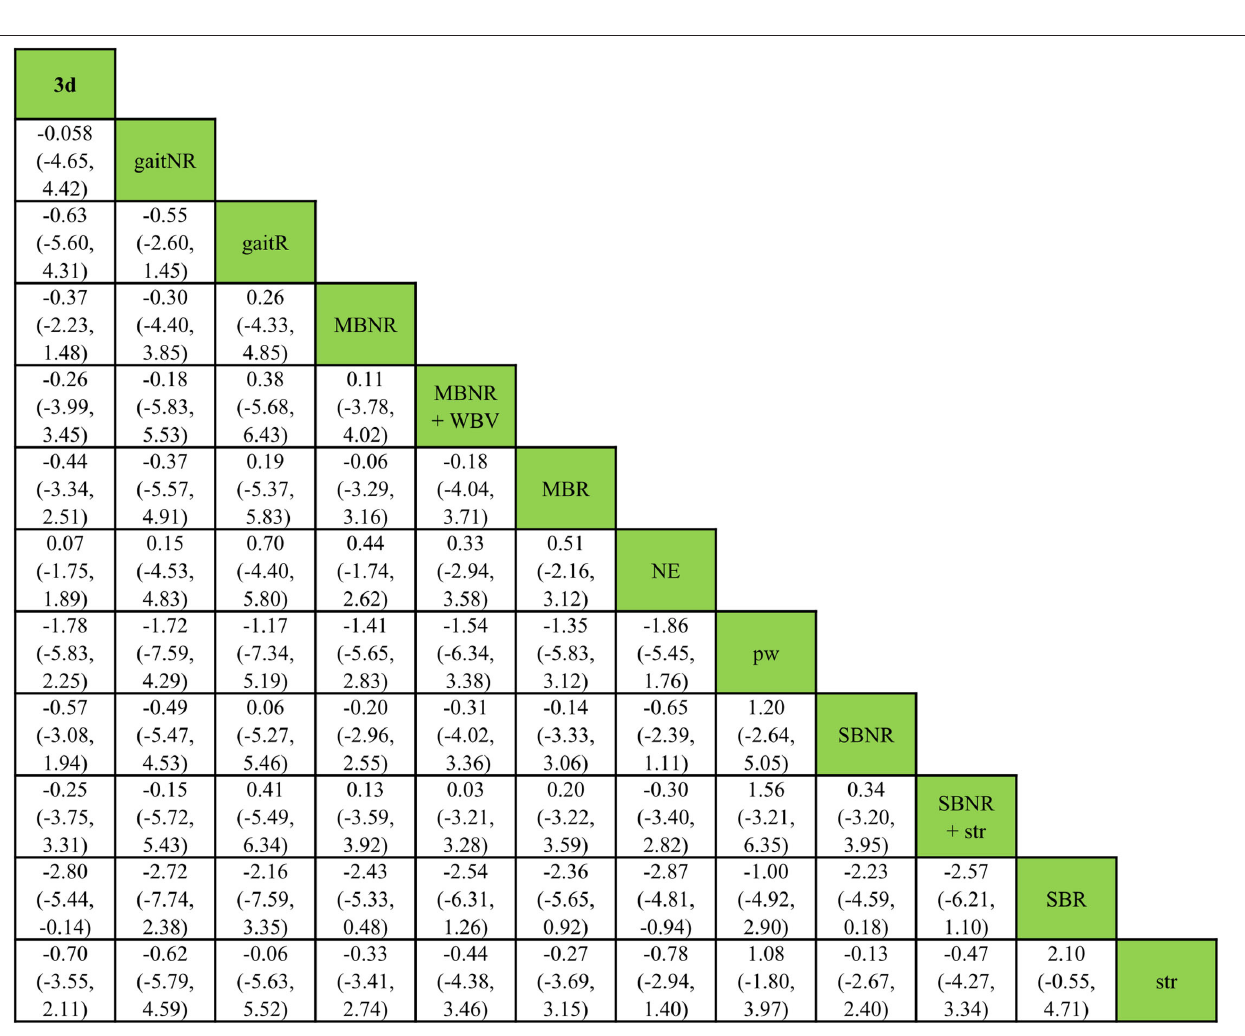
FIGURE 8 | Relative effect estimates with 95% credible intervals of all pairs of exercise interventions in healthy older